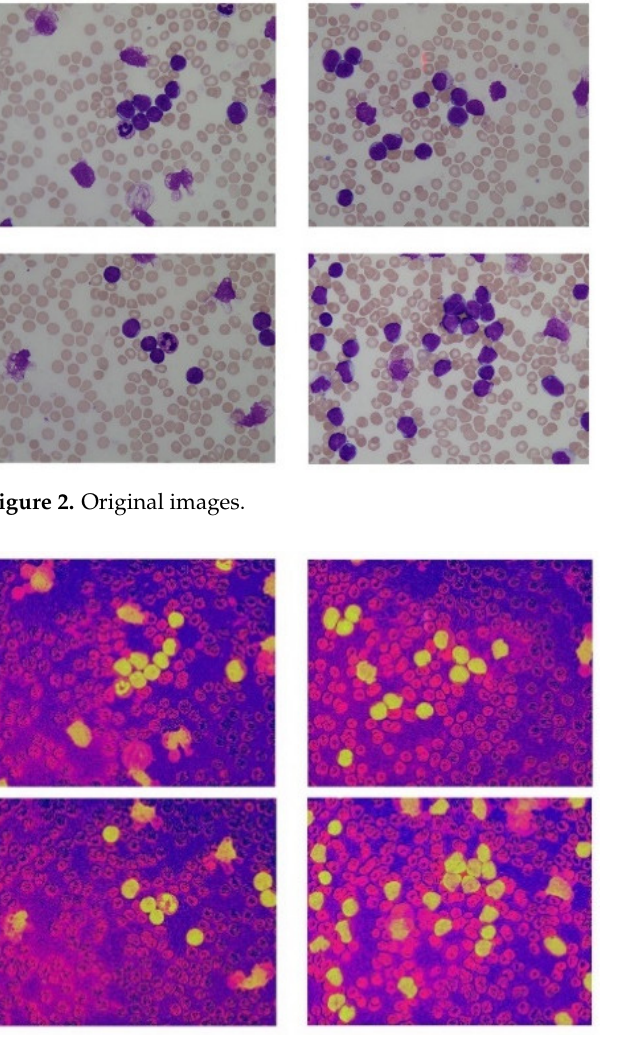
Figure 3. HIS color space.